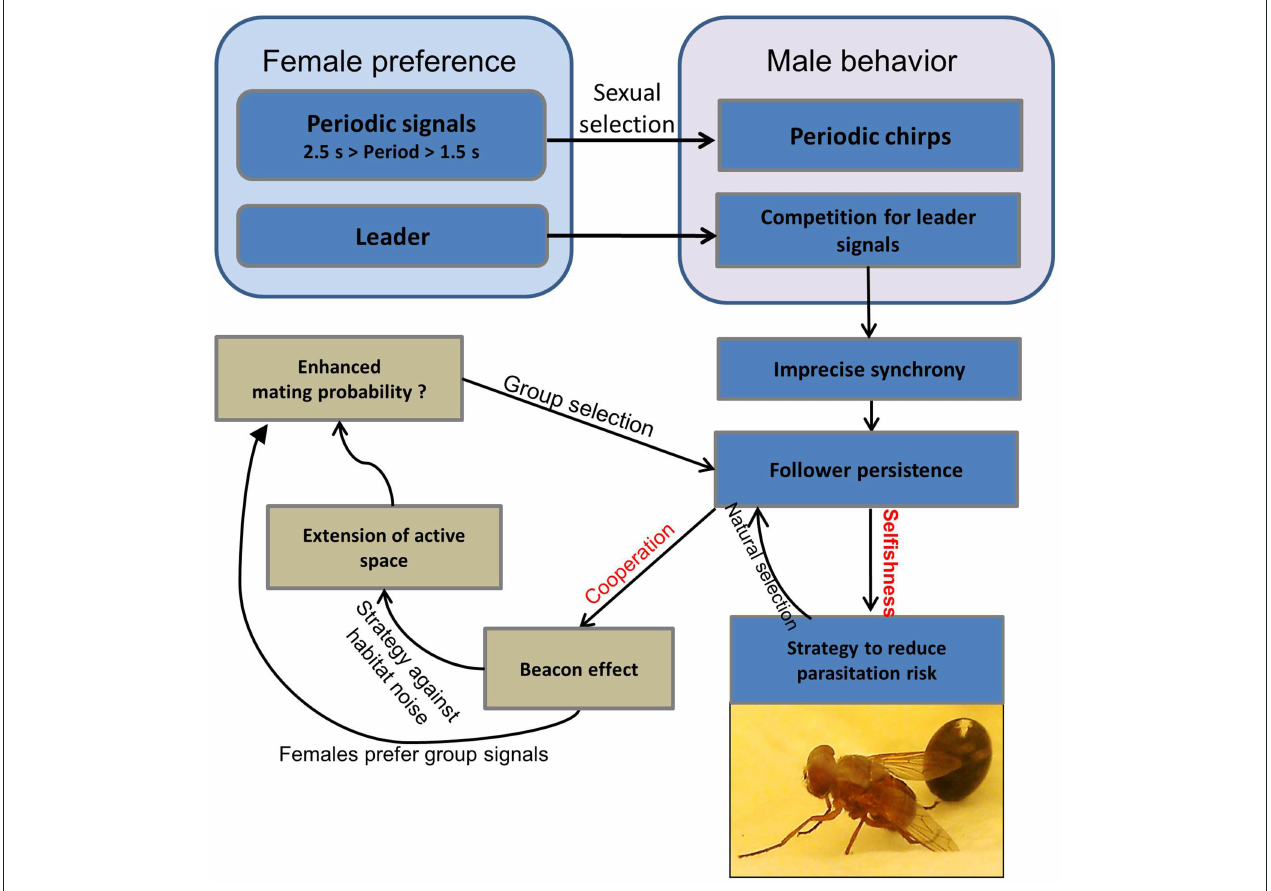
FIGURE 6 | Selection pressures potentially involved in the evolution of chorus synchrony in M. elongata . For explanation, see text (Section Cooperation, Competition, and a Trade-off between Natural and Sexual Selection). Parasitoid flies hatch from puparia (visible as the ball in the